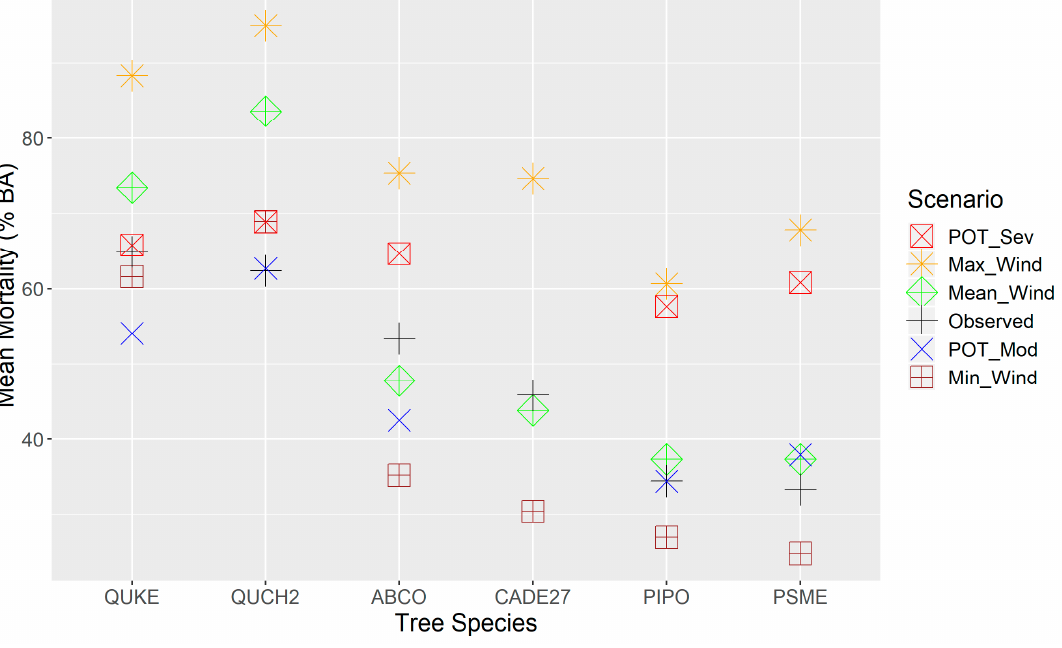
Figure 3. Mean mortality (% basal area (BA)) for the five most common tree species by weather scenario and observed. The key to species codes is in Table